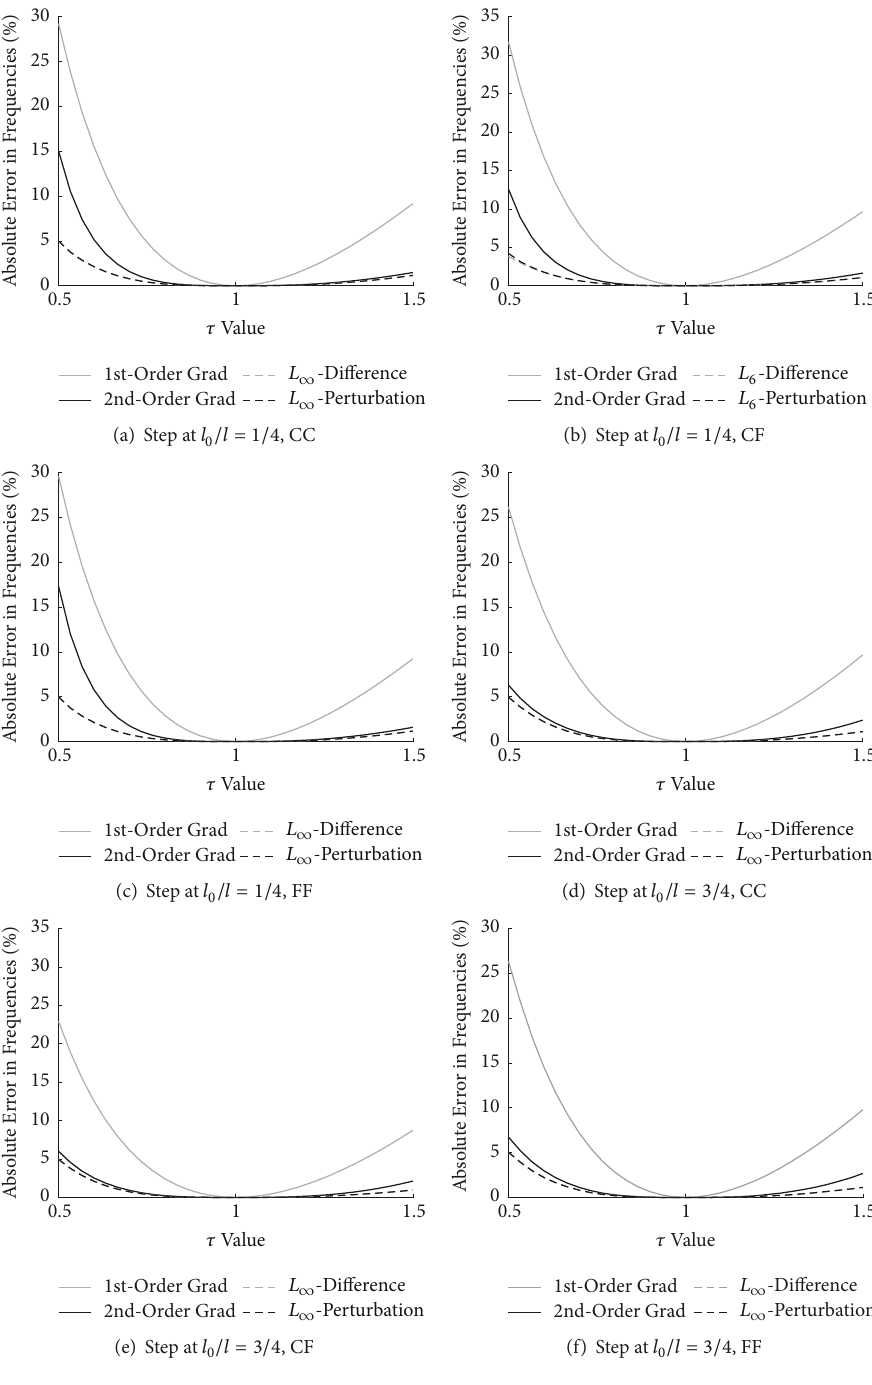
Figure 2: Frequency error results for variable 𝜏